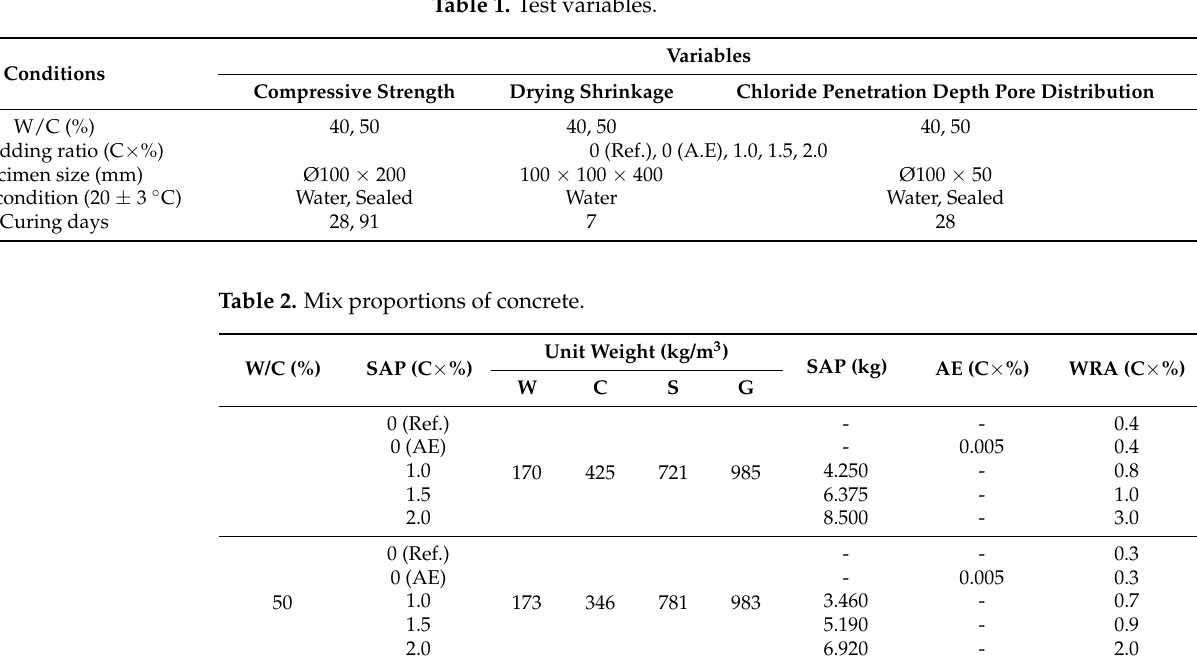
Table 1. Test variables.